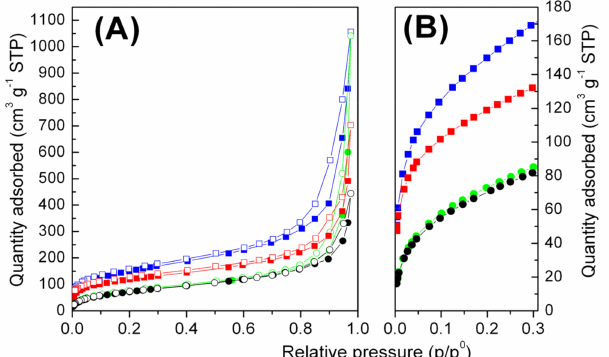
Figure 5. Volumetric N 2 adsorption–desorption isotherms at 77 K in the 0–1 P / P 0 range ( A ) and in the 0–0.3 P / P 0 range ( B ) of pure sPS (circles, green) and PPO (squares, blue) aerogels and of sPS / r-GO (circles, black) and PPO / r-GO (squares, red) nanocomposites aerogels containing 20 wt.% of r-GO. Filled and empty scatters refer to the adsorption and desorption branches,